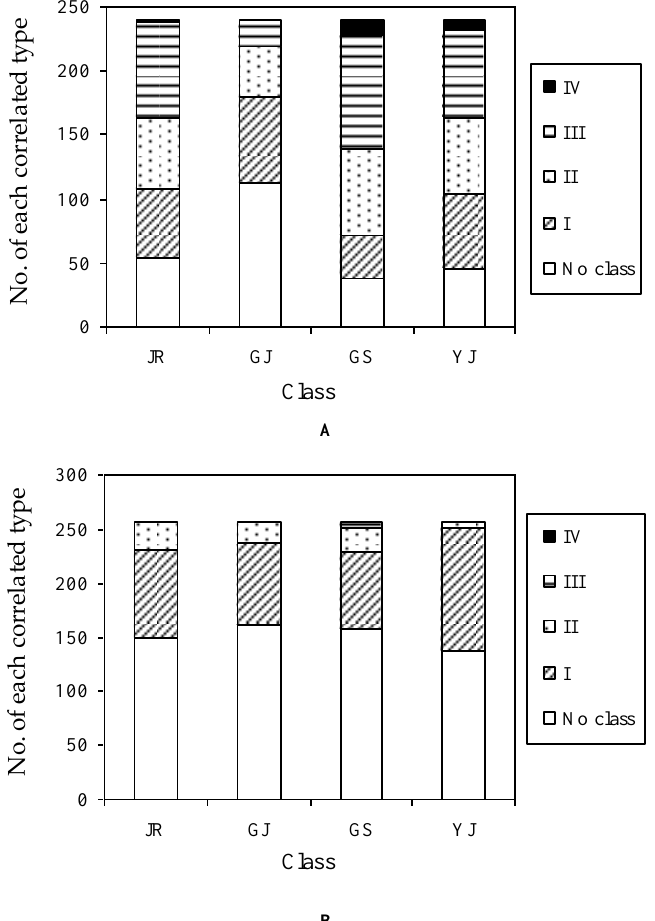
FIGURE 7. Relative abundance of the matching data pairs in terms of correlation strengths: (A) between different metals and (B) between metals and relevant parameters (criteria pollutants and meteorological